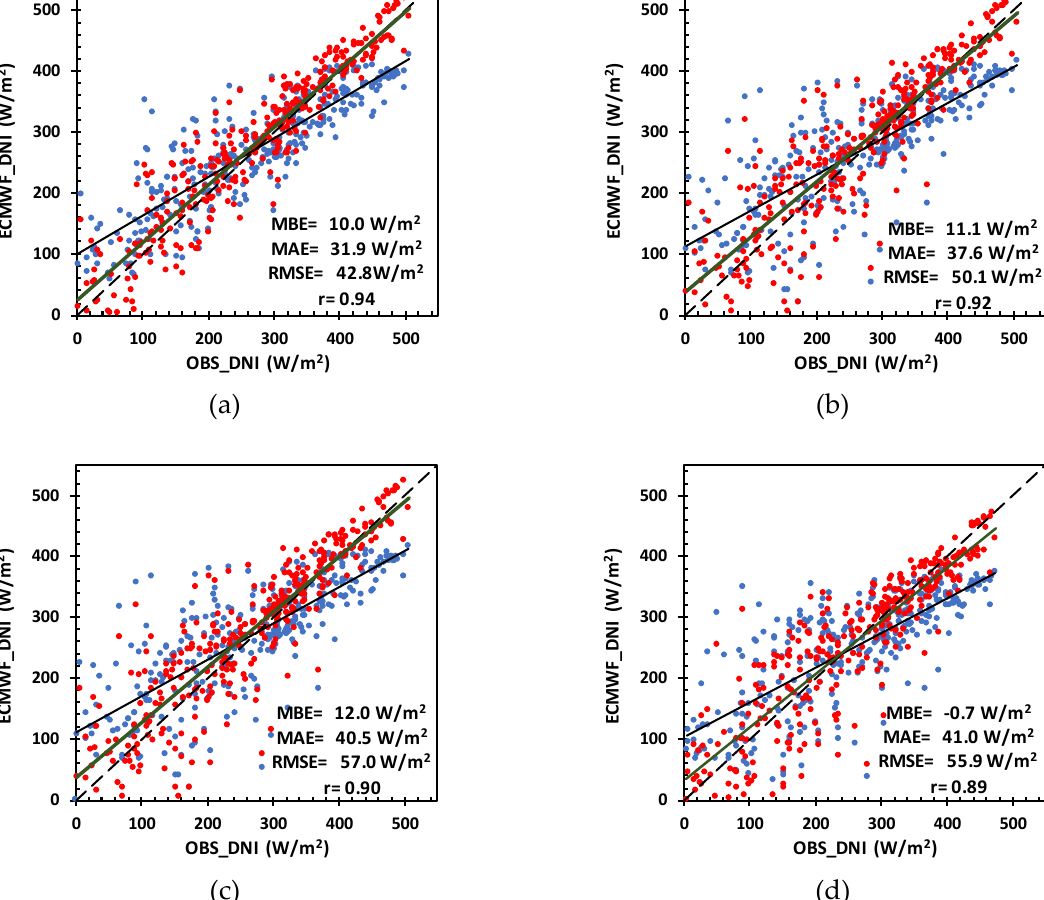
Figure 12. Comparison between predicted and measured daily mean DNI for the four prediction days: ( a ) day_0, ( b ) day_1; ( c ) day_2; ( d ) day_3 before (blue dots) and after Bias correction (red dots). MBE, MAE, RMSE, and r, after BC, are also presented in each plot. The solid lines are the linear fits-green for BC procedure and black for IFS / ECMWF raw data-and the dashed line represents the y = x line.